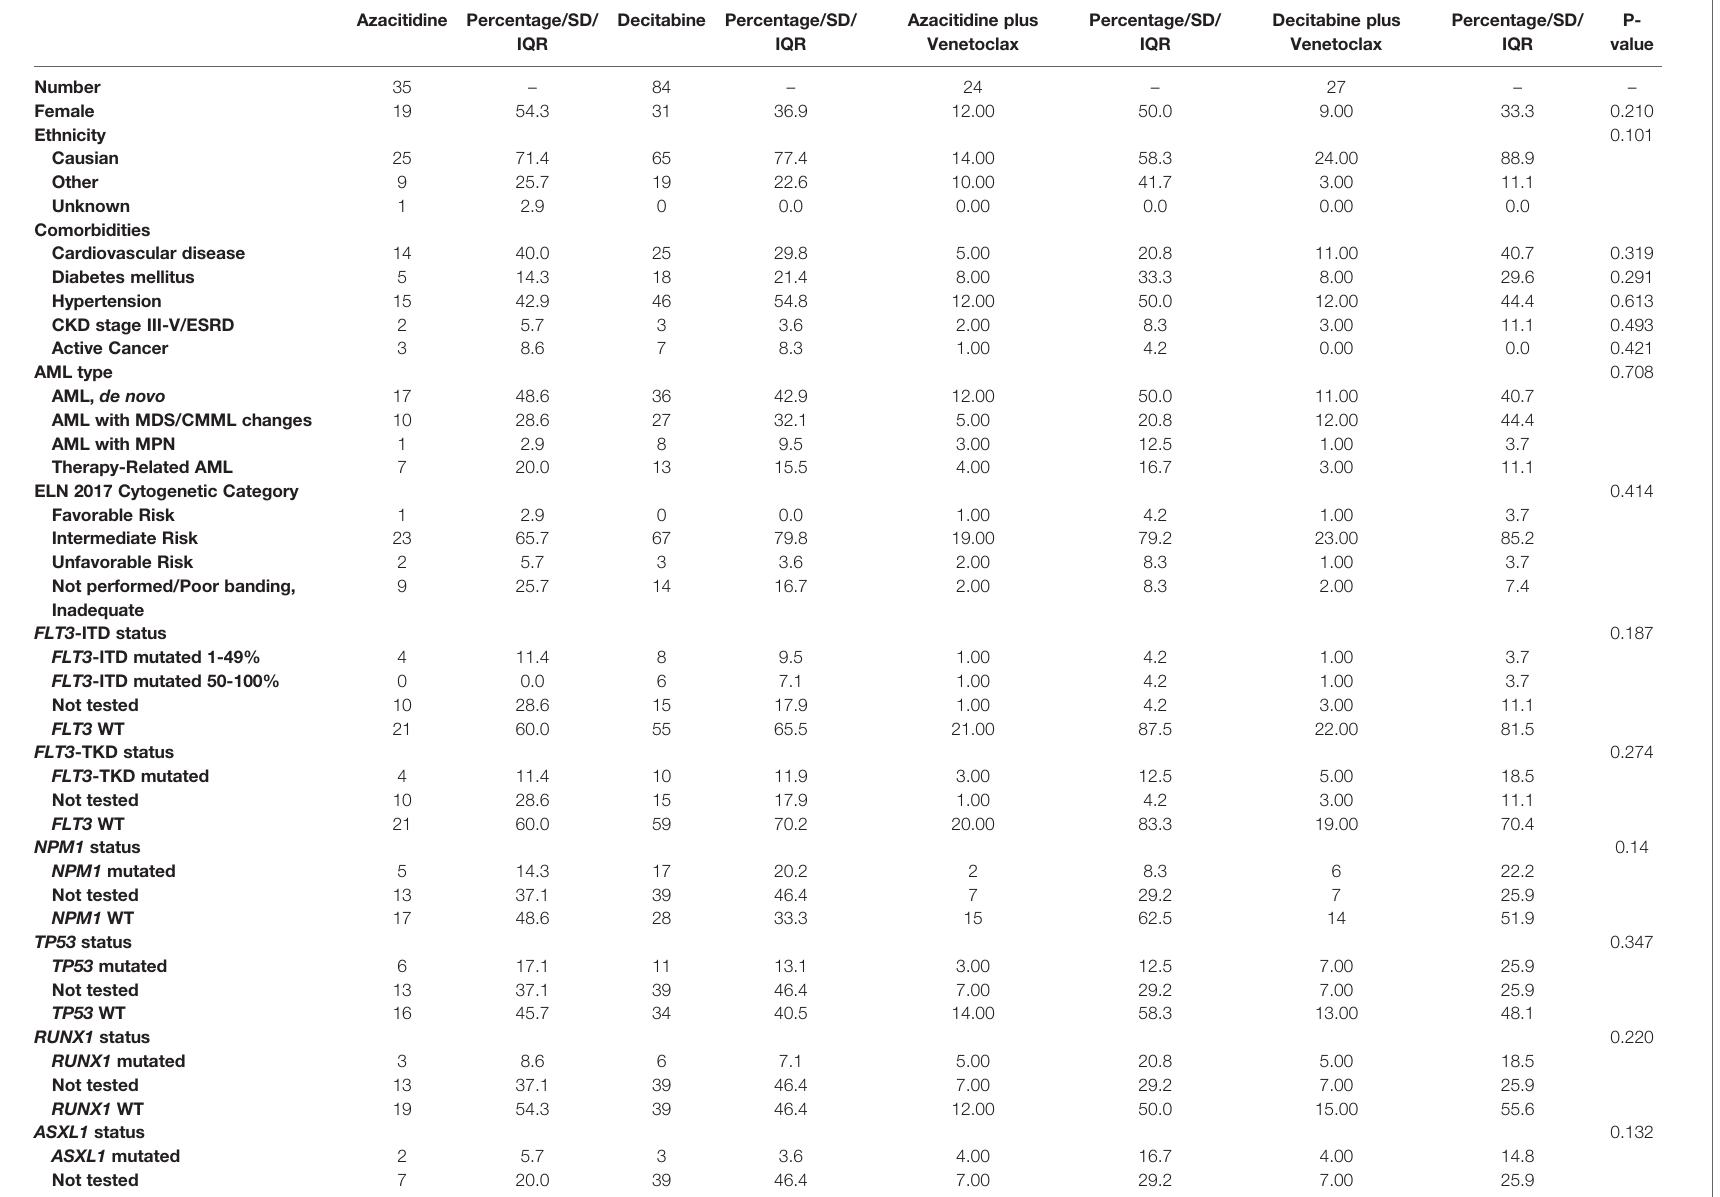
TABLE 1 | Baseline characteristics of newly diagnosed AML patients treated with azacitidine or decitabine with or without